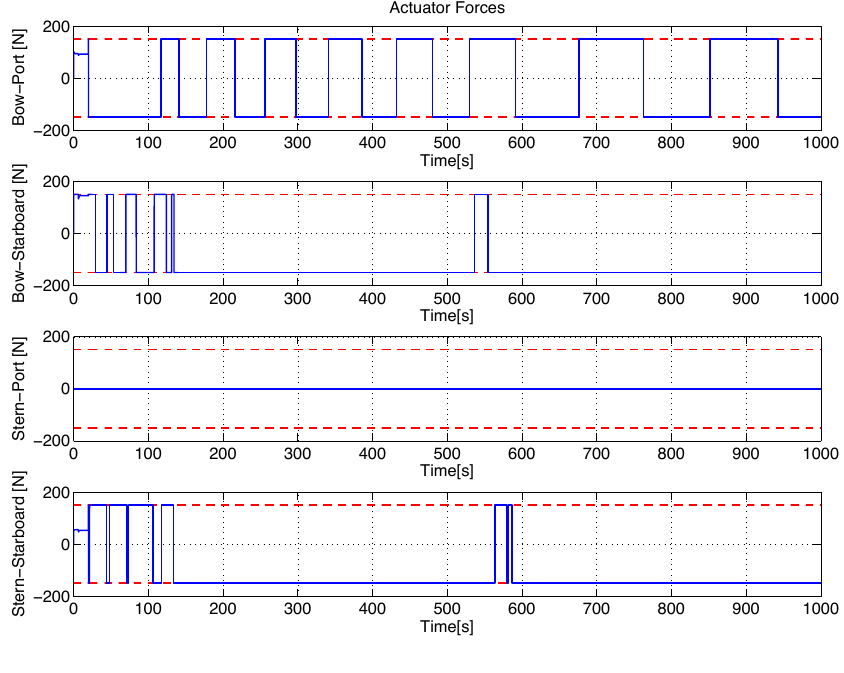
Figure 14: Actuator forces for a vehicle change in position while in current with an actuator fault, for the case where the anti-windup is not